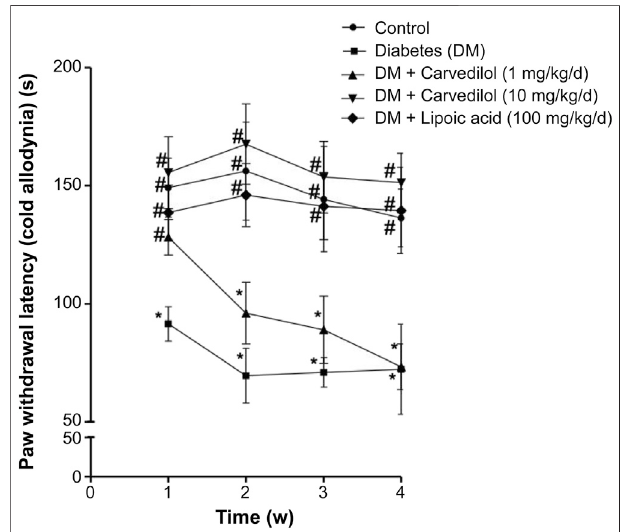
FIGURE 2 | The paw withdrawal latency to cold stimuli in STZ-induced diabetes in rats. Data are presented as mean ± SD for each group ( n (cid:2) 6). Statistical analysis was done by two-way ANOVA, followed by Tukey ’ s post- hoc test. *Statistically signi fi cant from the corresponding control group (group1)at p < 0.05.#Statisticallysigni fi cantfromthecorrespondingdiabetes group at p < 0.05. DM, diabetes mellitus; SD, standard deviation; STZ, streptozotocin; Time (w), time in